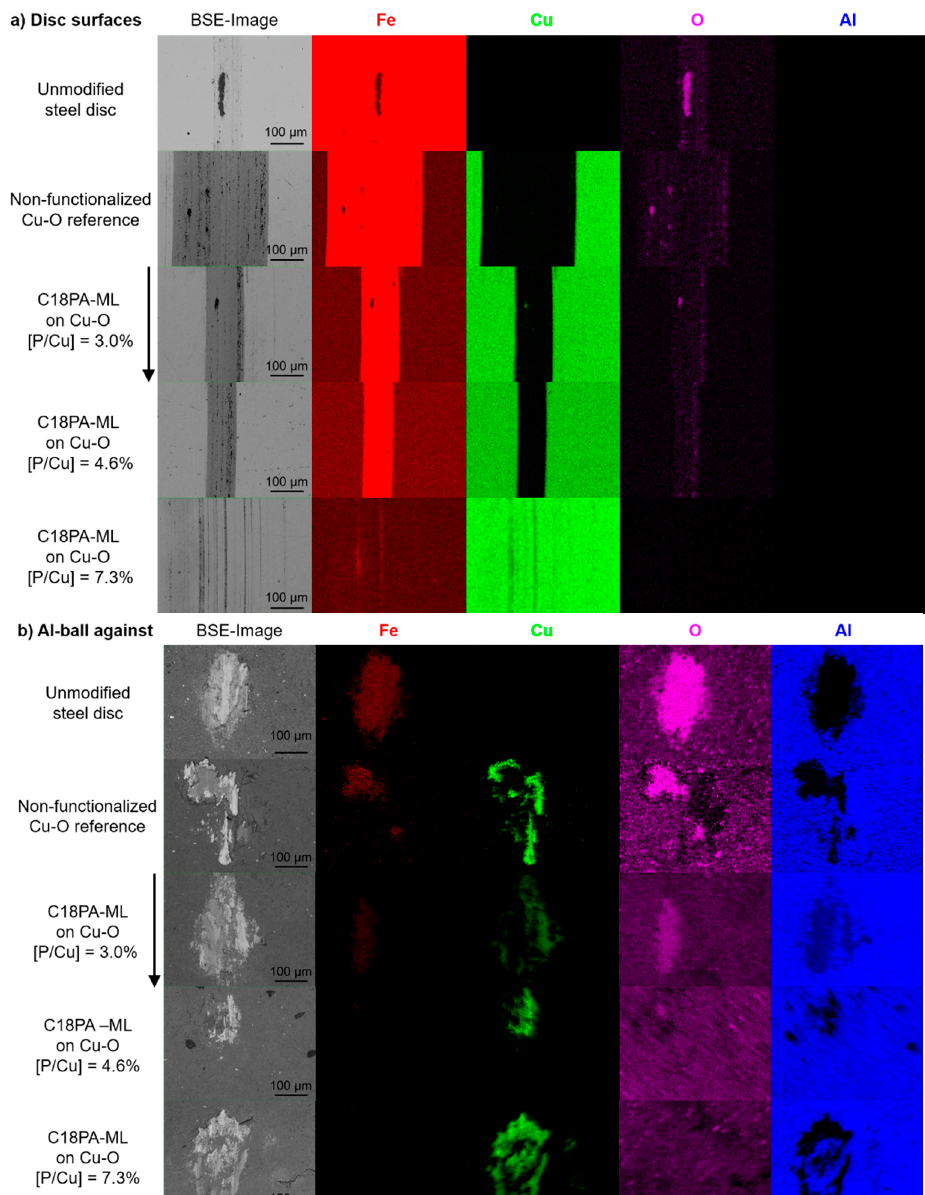
Figure 4. Elemental distribution of Cu–O surfaces coated on tool steel disks without and with C18PA functionalization of different molecular coverages and of an unmodified disk ( a ) as well as of corresponding aluminum counter-bodies ( b ) obtained by X-ray analysis (EDX) after ball-on-disk experiments. Coverages are indicated by the P/Cu-ratio, the sliding direction by an arrow.